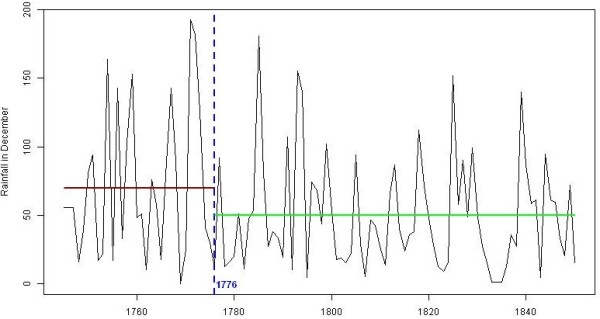
Rainfall in the December month before and after the breakpoint year (1776). The mean monthly total rainfall before and after this date is indicated by brown and green horizontal lines, respectively.